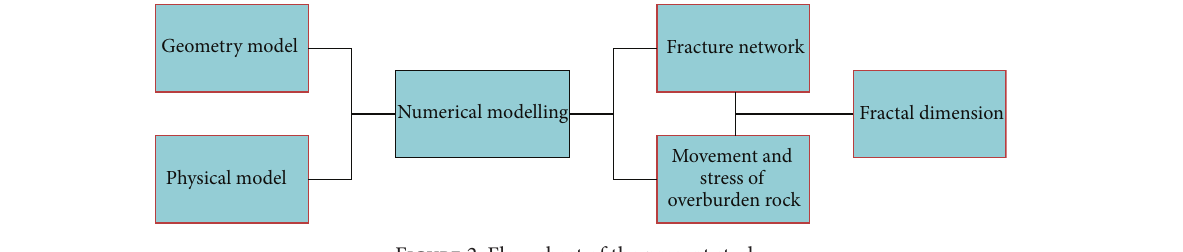
Figure 2: Flow chart of the present study. Table 1: Mechanical properties of